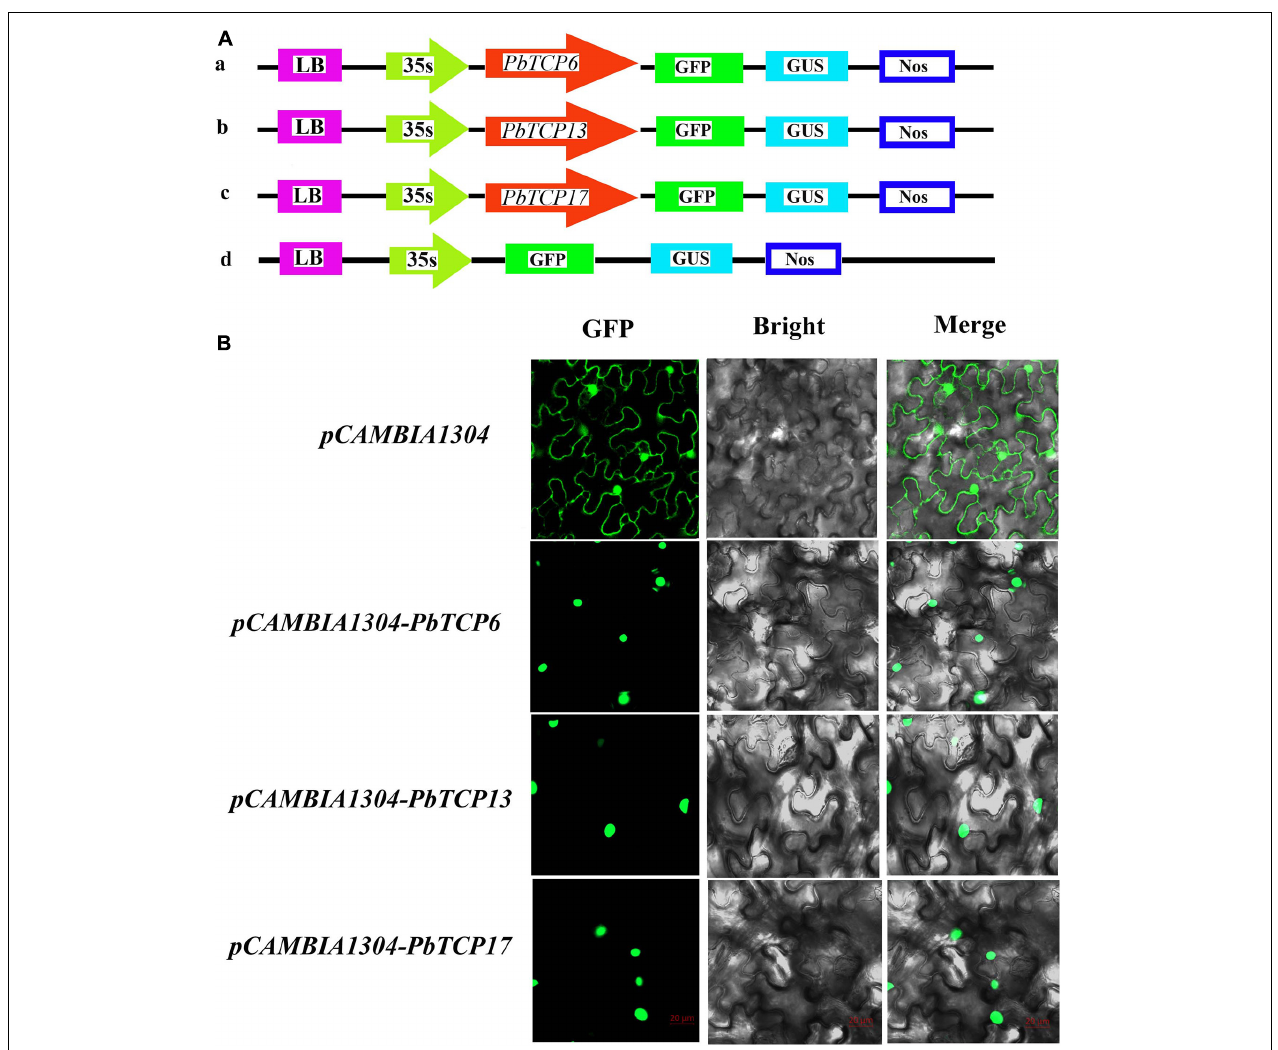
FIGURE 9 | Subcellular localization of three PbTCP genes. (A) Schematic illustration of vectors pCAMBIA1304 and PbTCPs . (B) The three pCAMBIA1304- PbTCPs fusion proteins (pCAMBIA1304- PbTCP6 , pCAMBIA1304- PbTCP13 , pCAMBIA1304- PbTCP17 ), and pCAMBIA1304 as a control were transiently expressed in tobacco leaf and observed under fluorescence